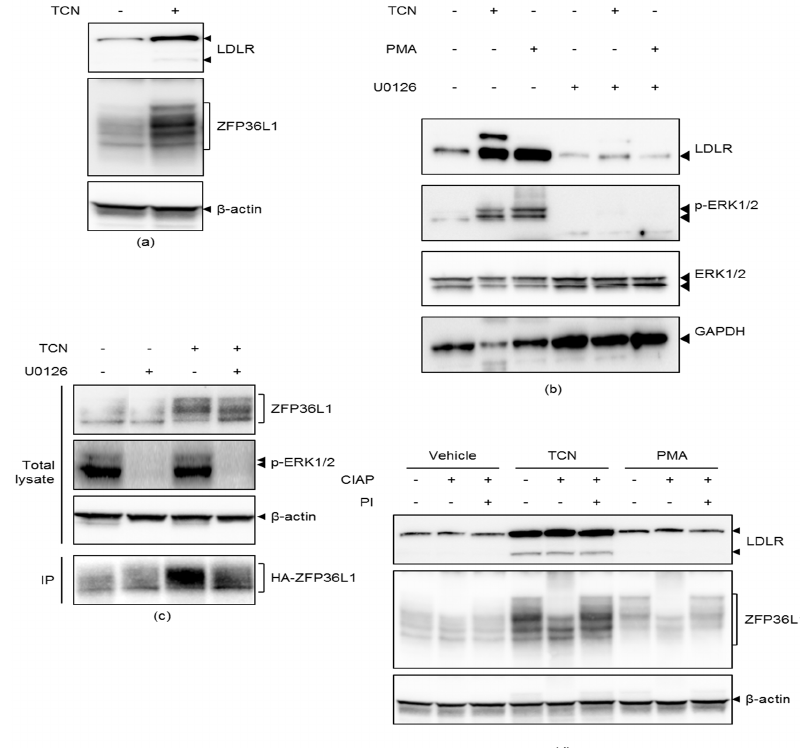
Figure 3. TCN induces phosphorylation of ZFP36L1 downstream of ERK. ( a ) HepG2 cells were exposed to TCN for four hours and lysates were immunoblotted with the indicated antibodies. One representative blot is shown, ( n = 3). ( b ) Cells were exposed to U0126 for one hour before treatment with TCN or phorbol 12-myristate 13-acetate (PMA) for four hours. Lysates were immunoblotted with the indicated antibodies. ( c ) Cells were transfected with pcDNA4 / TO-HA-ZFP36L1 and the day after transfection added U0126 for one hour, prior to addition of TCN for four hours. Lysate were subjected to immunoblotting with the indicated antibodies. IP: immunoprecipitation. ( d ) Cells were exposed to TCN for four hours or PMA for one hour. 25 µ g of total lysate were treated as indicated and subjected to immunoblotting using the indicated antibodies. CIAP (calf intestinal alkaline phosphatase), PI (phosphatase inhibitor). One representative blot is shown, ( n =